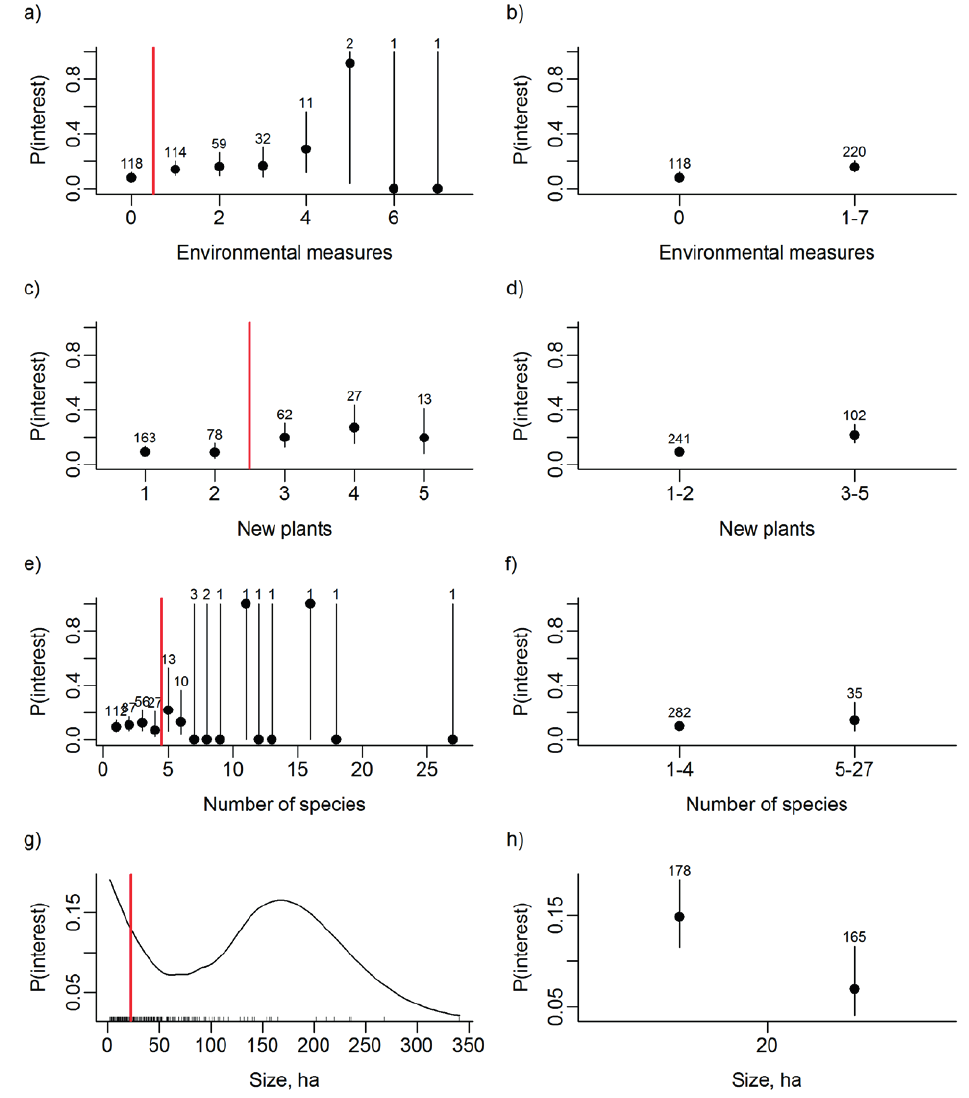
Fig. S3. Probability of interest in organic production as a function of those explanatory variables, which were aggregated directly according to the classification tree. The left hand panel shows the models using the original variables and the right hand panel those using the aggregated variables.